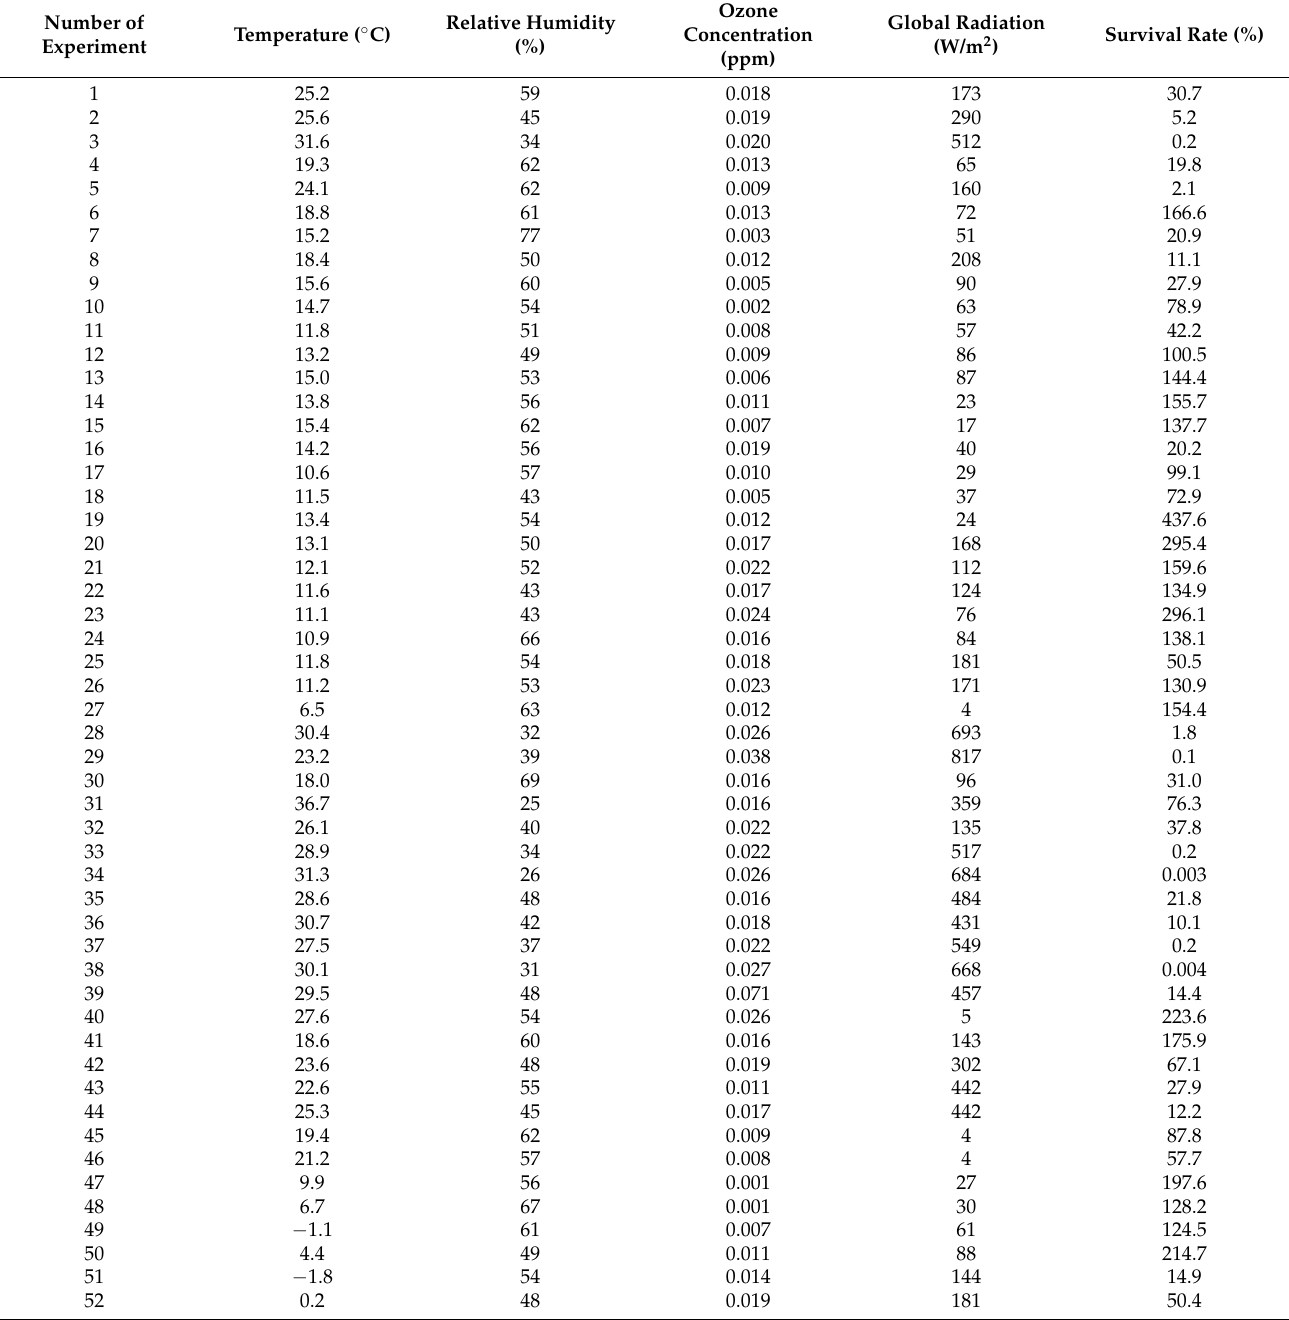
Table 1. Mean values of temperature, relative humidity, ozone concentration, and global radiation for the 52 individual experiments in the chamber and the survival rates